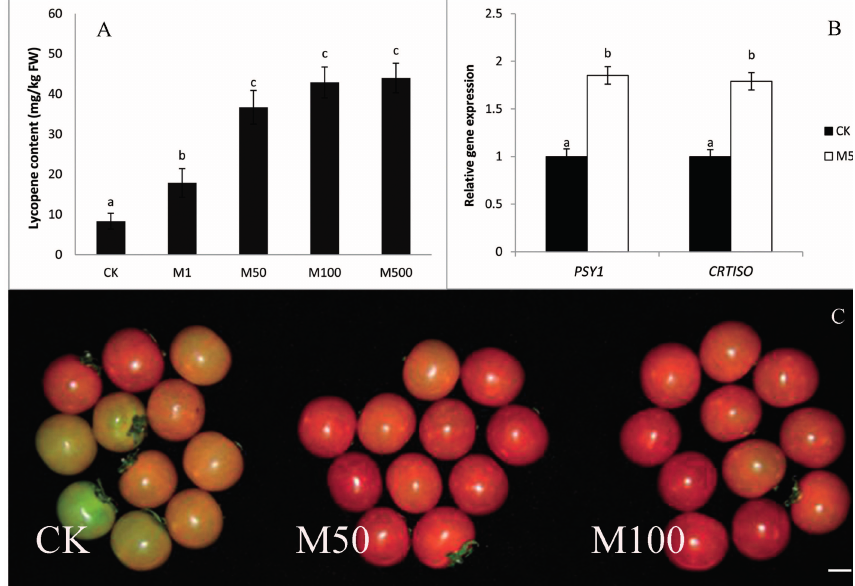
Figure 12. Influence of melatonin pigment accumulation in Bmei cherry tomatoes. Freshly-picked green tomatoes were insulated in a solution containing 1 µM (M1), 50 µM (M50), 100 µM (M100) or 500 µM (M500) melatonin solution for 45 minutes. Thereafter, the tomatoes were stored for 25 days. Melatonin hastens lycopene ( A ) accumulation in a concentration-dependent manner; ( B ) PCR analysis of PSY1 and CRTISO gene expression in control (CK) and 50 µM-treated tomatoes; PSY1 and CRTISO are involved in lycopene synthesis; ( C ) Tomatoes treated without melatonin (CK) or with different concentrations of melatonin (M50 or M100); see text for details. Bars with different letters (a,b or c) differ statistically significantly. From Sun et al. [202] with